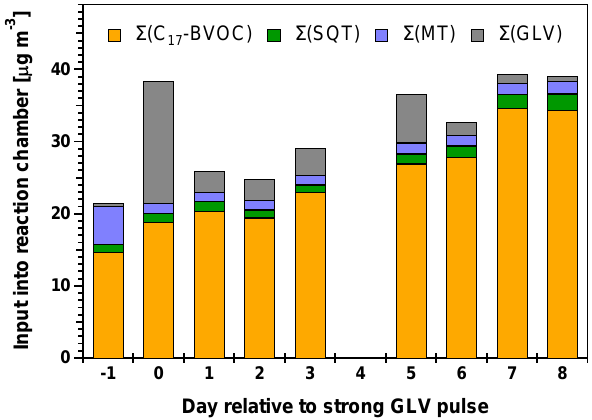
Fig. 6. BVOC pattern in Experiment #3 measured before, during and after a GLV emission pulse. Day 4 is missing because of an instrument failure.